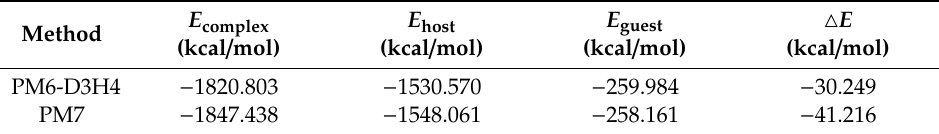
Table 2. Final heat of formation energy ( E ) and the complexation energy ( ∆ E ) for the HP- β -CD: myricetin complex from semi-empirical quantum mechanical PM6 and PM7 methods.